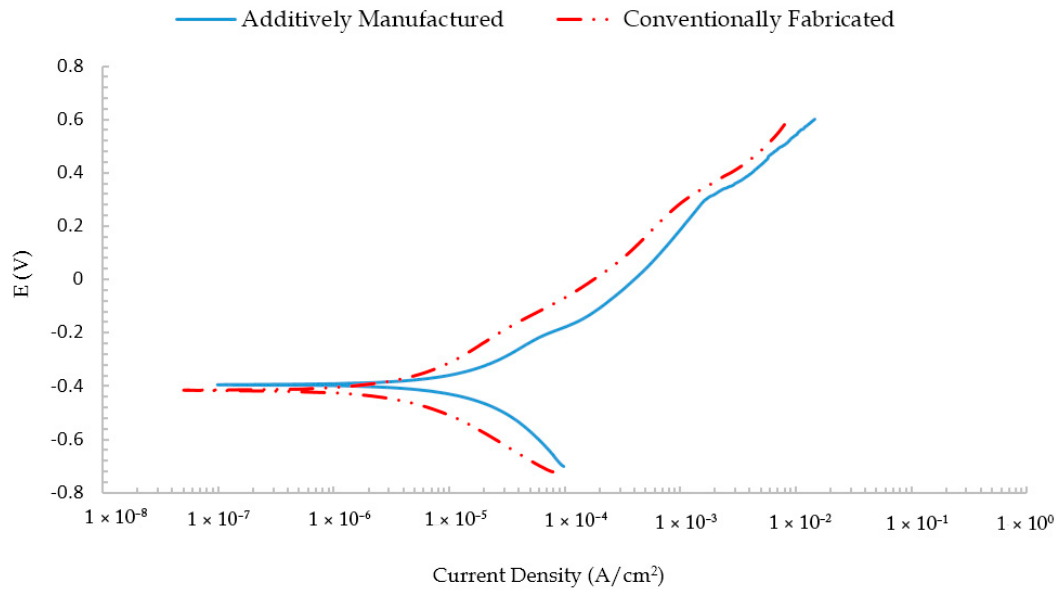
Figure 5. The potentiodynamic polarization curves of the conventionally fabricated and additively manufactured NiTi alloy samples.